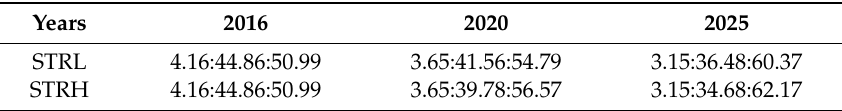
Table 6. Three industries structure under different structure effects.